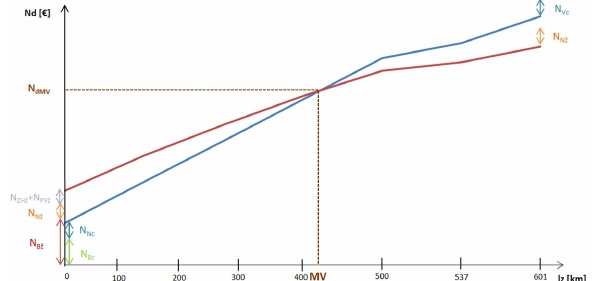
Figure 2: Graphical representation of threshold distance determina- tion based on the delivery costs from the consignor to consignee applied to a particular case in the SR [authors]